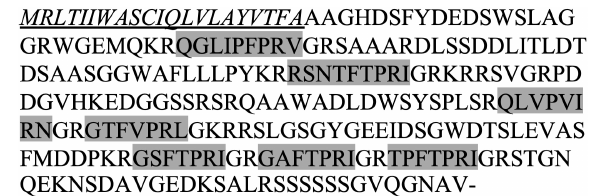
FIGURE 1 | Rhipicephalus sanguineus CAPA propeptide. The signal peptide (underlined and italic) was predicted using SignaIP version 5.0, and two periviscerokinins (PVKs) and five pyrokinin (PK) neuropeptides (gray highlights) were predicted by identification of the proteolytic cleavage sites following the rules suggested by Veenstra